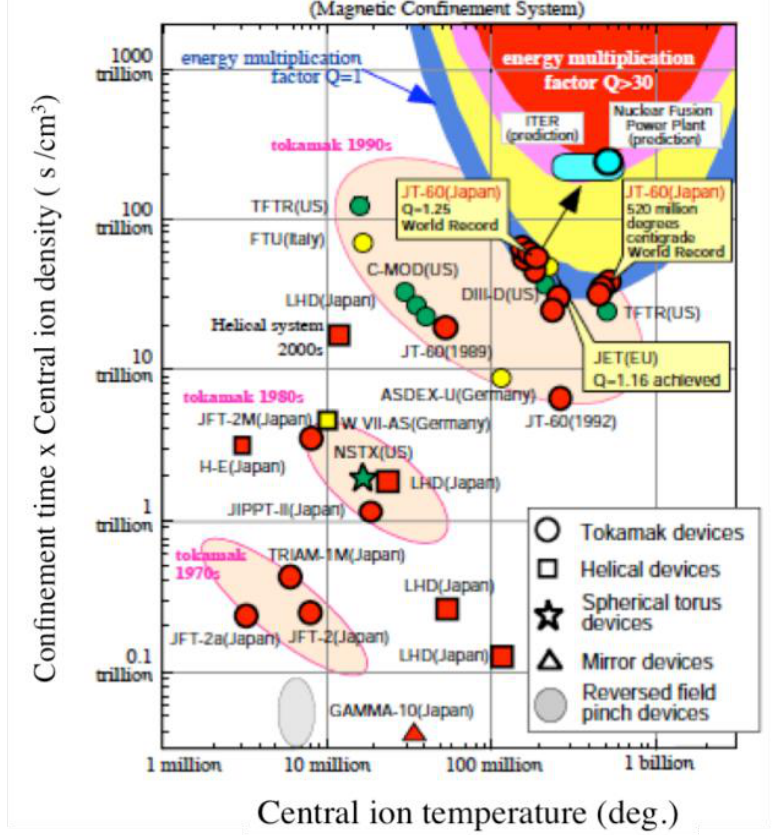
Figure 5. Lawson diagram (T progresses by decades (1970s, 1980s, 1990s) to reach break-even conditions. The key is to achieve good confinement with collisionless high temperature plasmas.